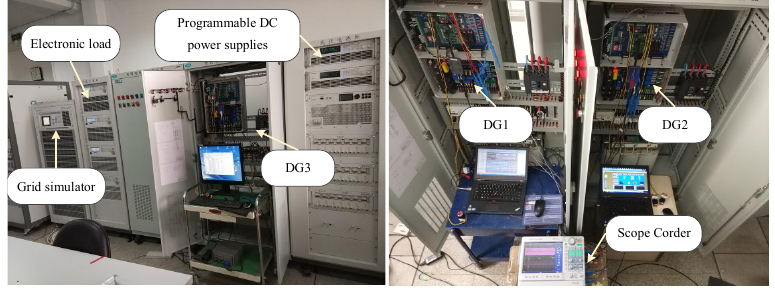
P 1 Figure 4. Experiment platform of